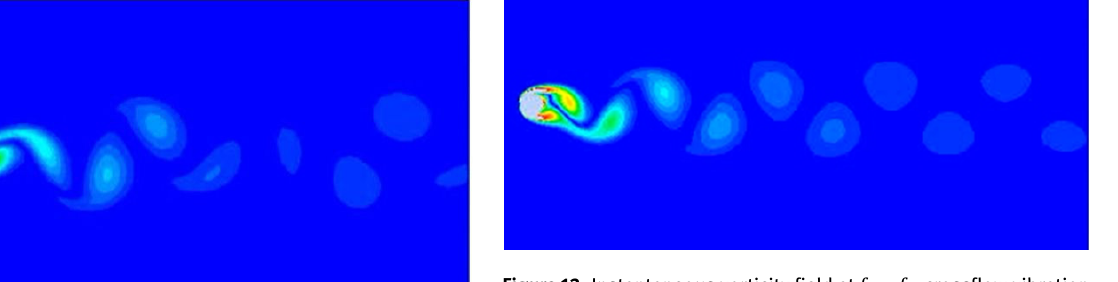
Figure 12: Instantaneous vorticity field at f v = f s , crossflow